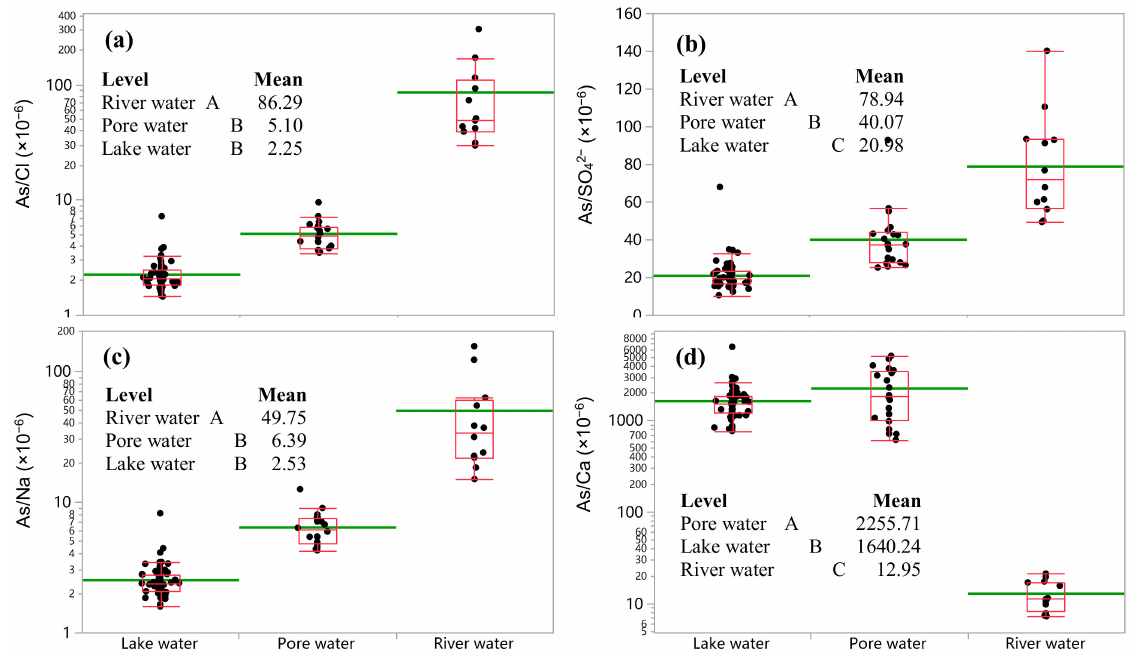
Figure 5. Raito of As to major or reference elements (( a ): Cl, ( b ): SO 42 − , ( c ): Na, ( d ): Ca) in the river water, lake water and pore